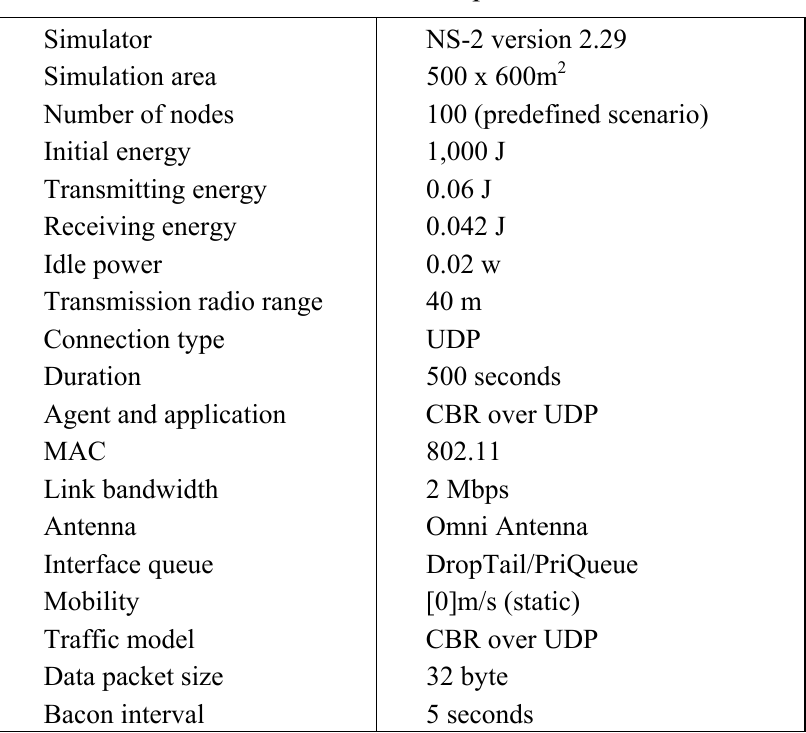
Table 2. Simulation